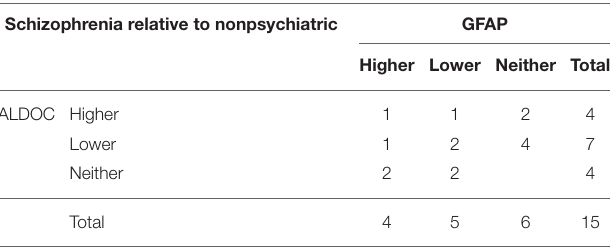
TABLE 5 | Astrocytic proteins most commonly